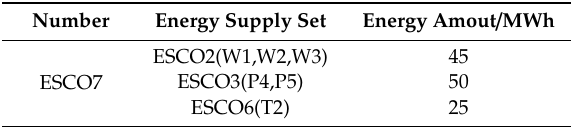
Table 5. Simulation results of ESCO7 in the